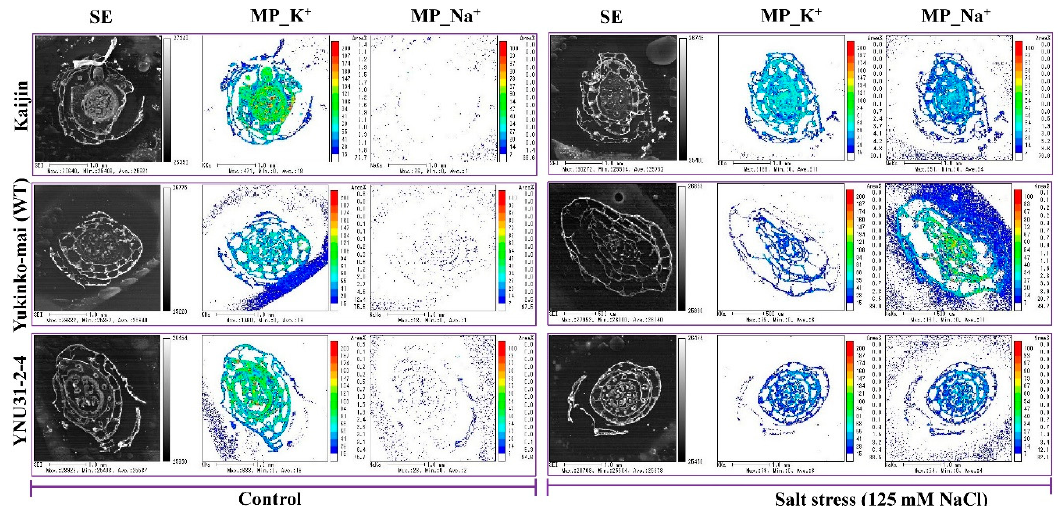
Figure 6. Accumulation and distribution of K + and Na + in cell clusters of 20-day-old seedlings. Relative amounts of K + and Na + are indicated by color coding. SE, secondary electron image; MP_K + , mapping pattern of K + ; MP_Na + , mapping pattern of Na + .